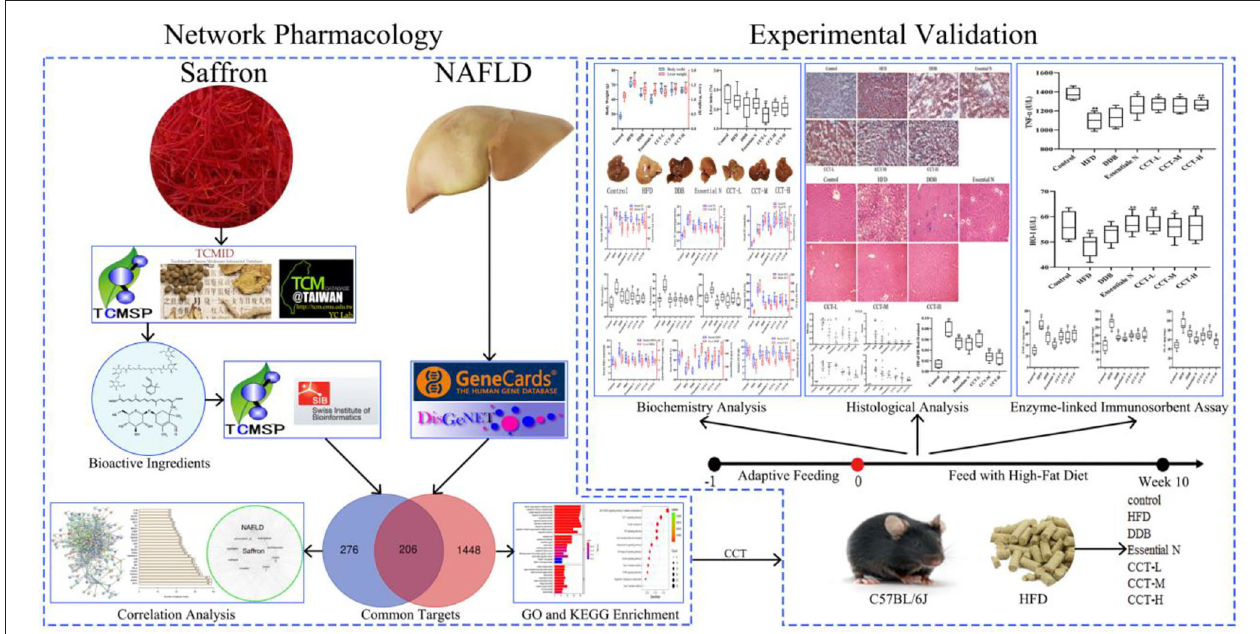
FIGURE 1 | The schematic diagram of the present